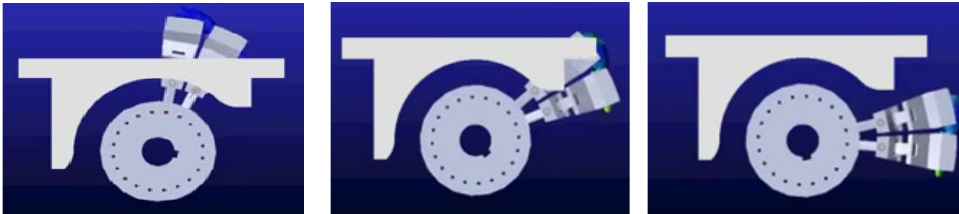
Figure 20. Simulation motion process of clamping mechanism.